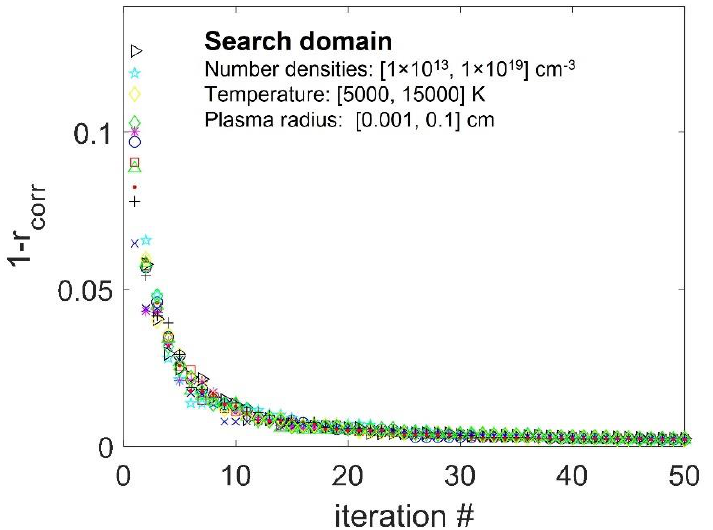
Figure 2. Convergence of the cost function as the function of the number of iterations. Starting from a random configuration, 11 runs were performed. Different symbols correspond to different initial configurations.